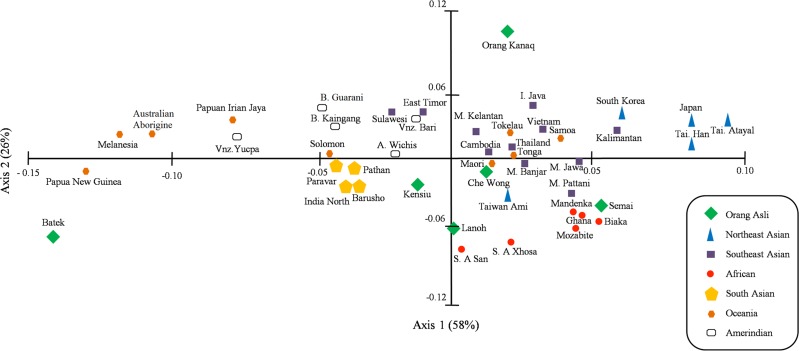
Principal component analysis plot shows the distribution of global populations based on KIR genes.All estimated KIR genes frequencies (gF) of the populations used are listed in S5 Table. A = Argentina; B = Brazil; I = Indonesia; M = Malay; S. A = South Africa; Tai = Taiwan; Vnz = Venezuela.